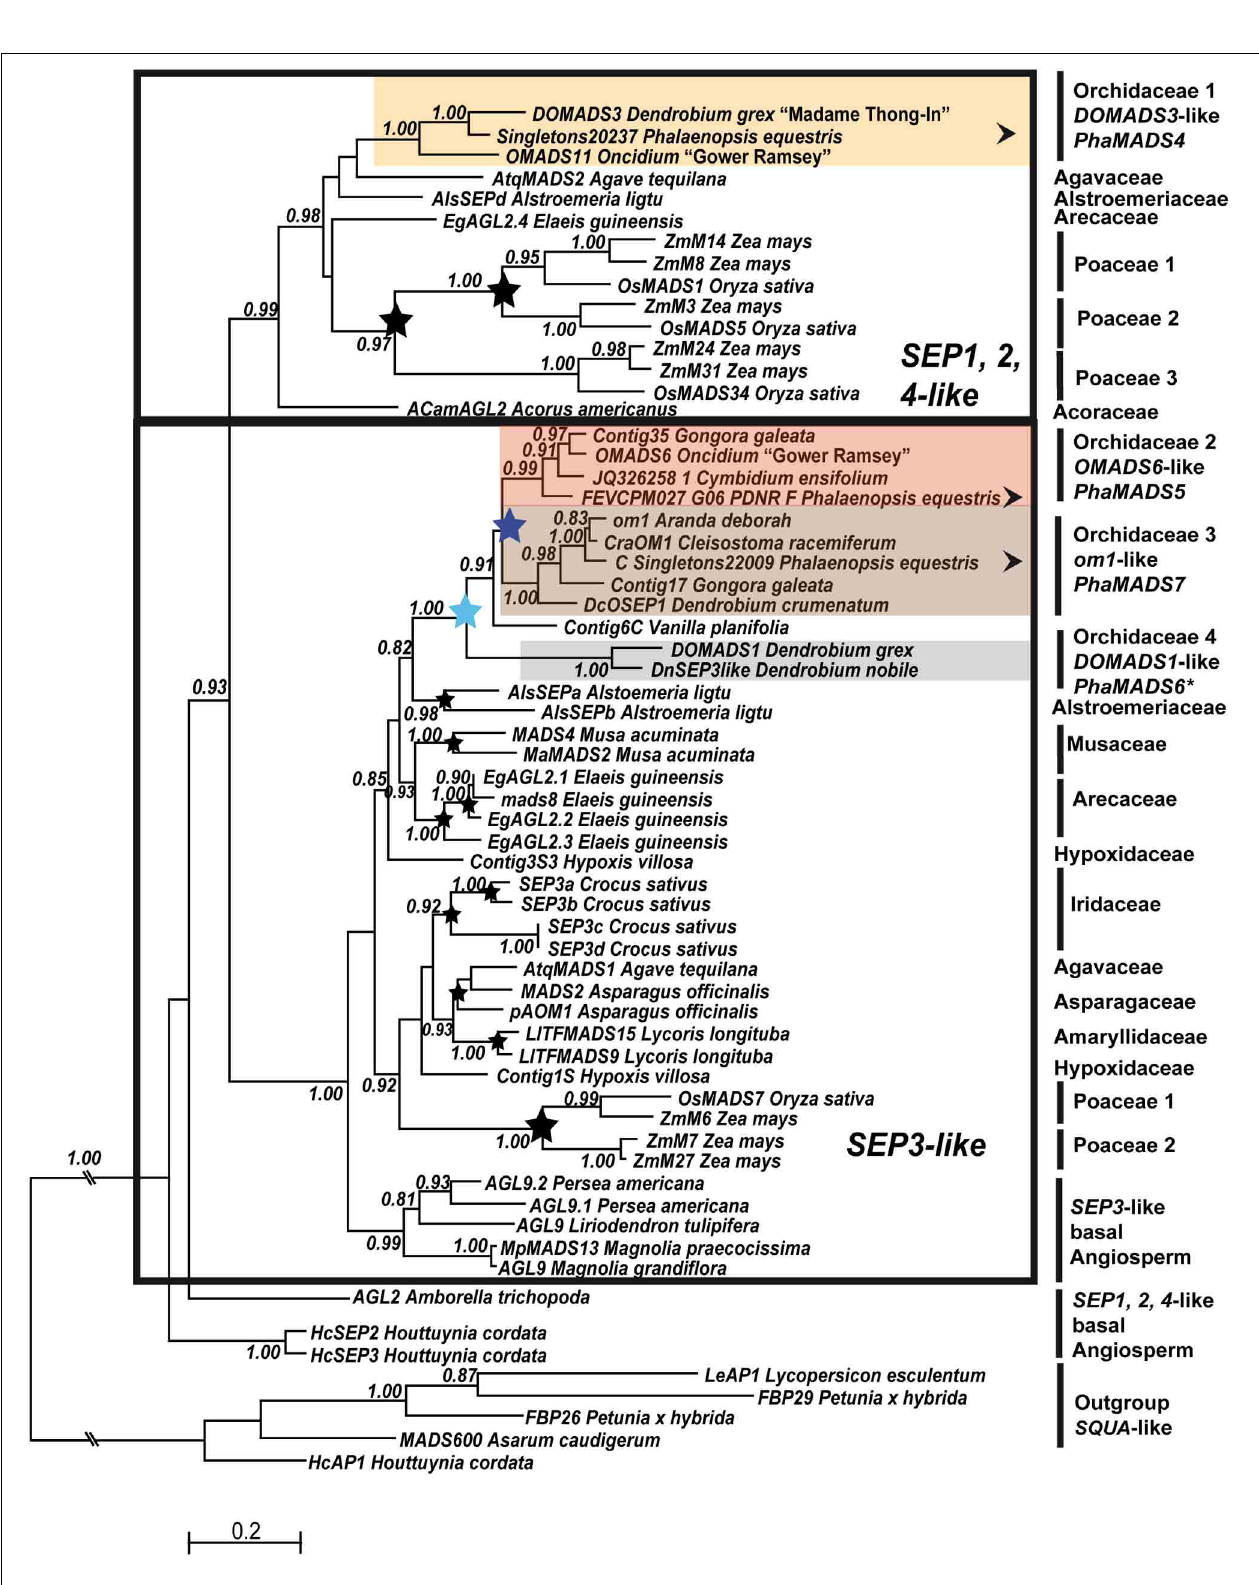
FIGURE 3 | Maximum Likelihood phylogeny of monocot SEP -like genes. The two major monocot clades previously identified are indicated with a black frame (Zahn et al., 2005a). Orchidaceae-specific clades and other annotations are as described in Figure 2 .